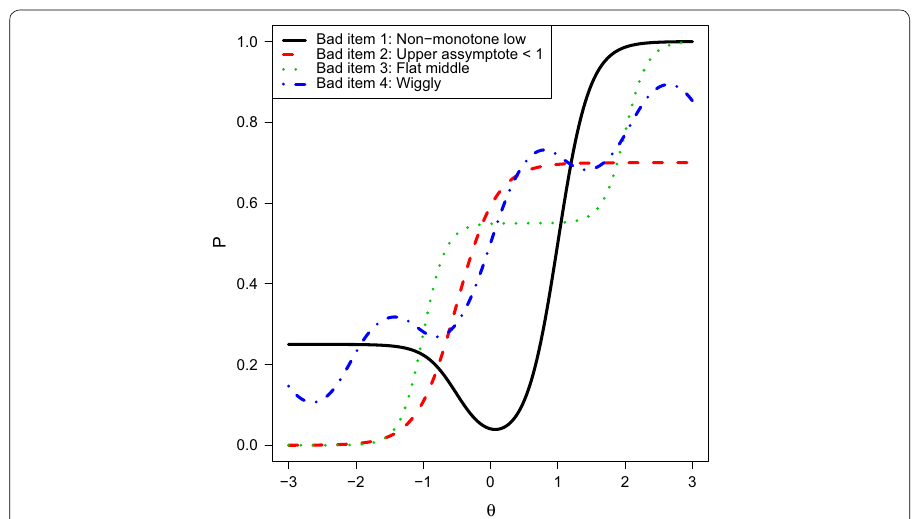
Fig. 3 Item response functions for each of the four bad item